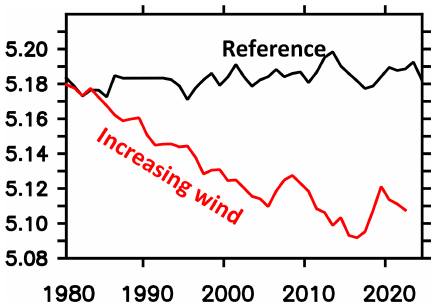
Figure 13. Simulated sea surface temperature averaged over the Southern Ocean (i.e., south of 40 ◦ S). The black (red) line refers to the reference (increasing wind) simulation.